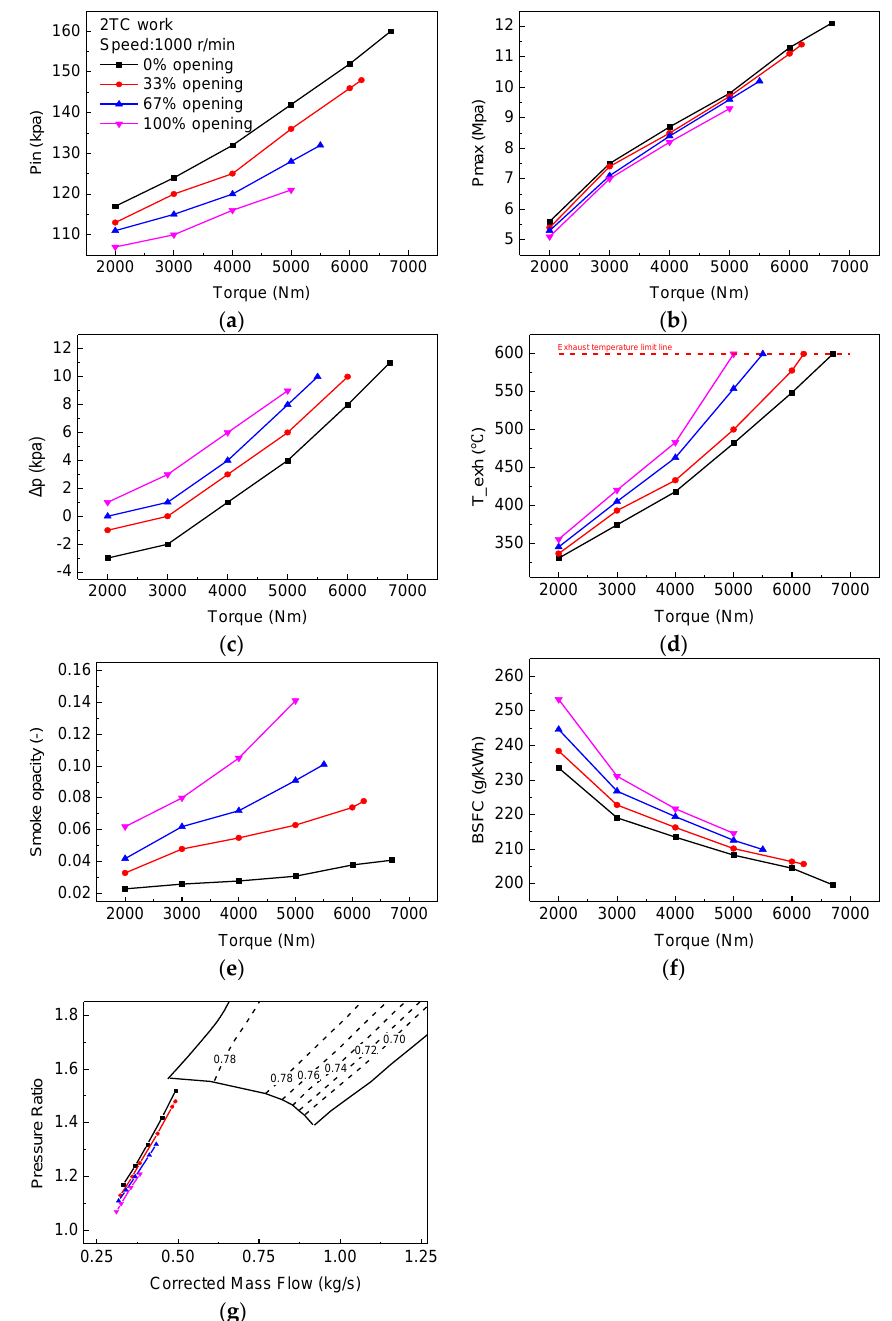
Figure 2. Variations of the main engine parameters at 1000 r/min with the 2TC. ( a ) intake pressure. ( b ) the maximum combustion pressure. ( c ) difference between the intake and exhaust pressures. ( d ) ex- haust temperature. ( e ) smoke opacity. ( f ) the brake specific fuel consumption. ( g ) compressor map.